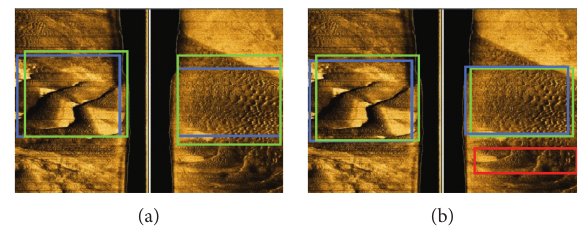
Figure 8: Comparison of target detection results at different scales.